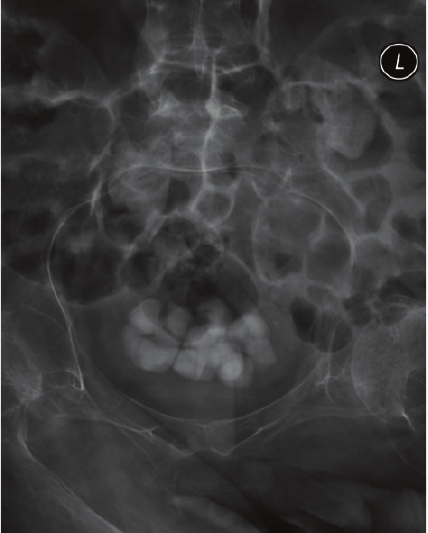
Figure 1: X-ray of abdomen, performed on 05 December 2008, revealed multiple calculi in urinary